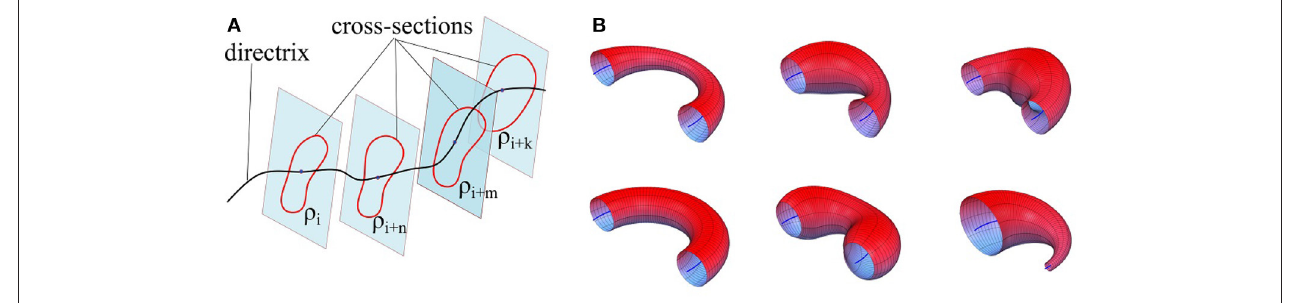
FIGURE 2 | (A) Formation of a generalized cylinder by translating the cross-sectional curve along the directrix. (B) Six generalized cylinders with identical directrices and different cross-sectional